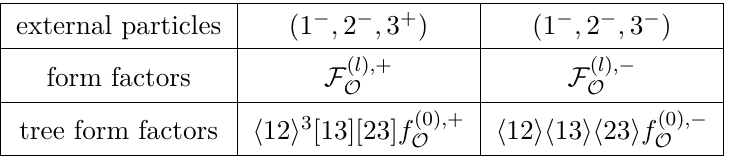
Table 10 . Notation of form factors with three gluons, where ± indicates positive or negative helicity gluons. f (0) , ± are scalar factors that depend on the dimension of the O